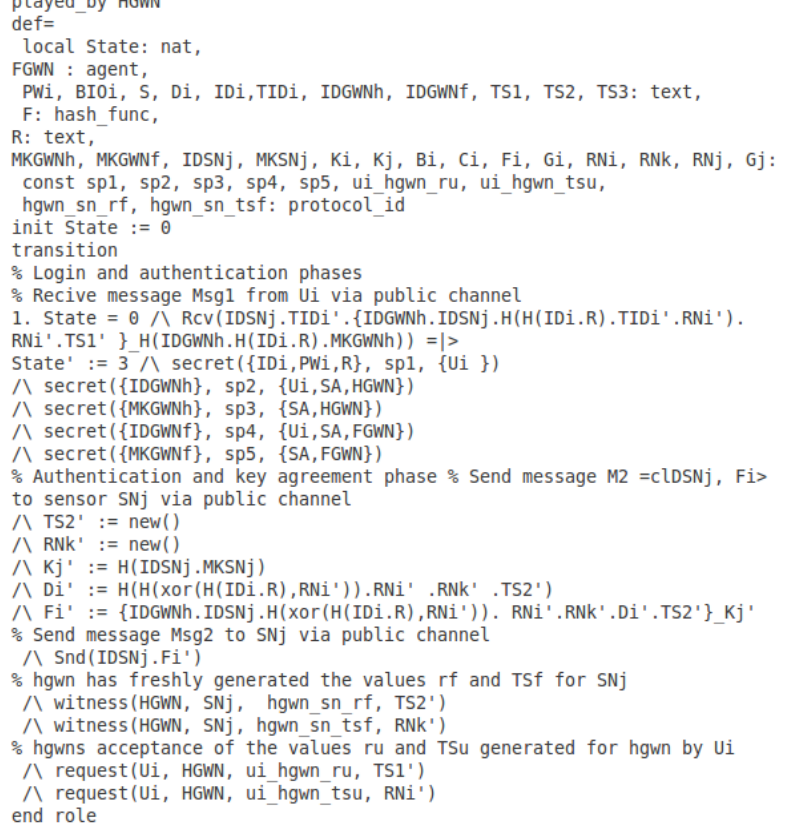
Figure 12. The home gateway role in